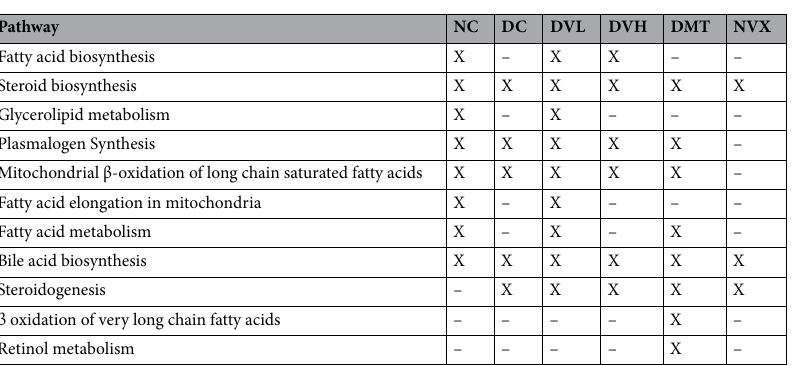
Table 2. Identified pathways in muscle tissues of experimental groups. X = present; – = not present. NC = NORMAL rats, DC = diabetic control, DVL = diabetic rats + vanillin (150 mg/kg b.w), DVH =